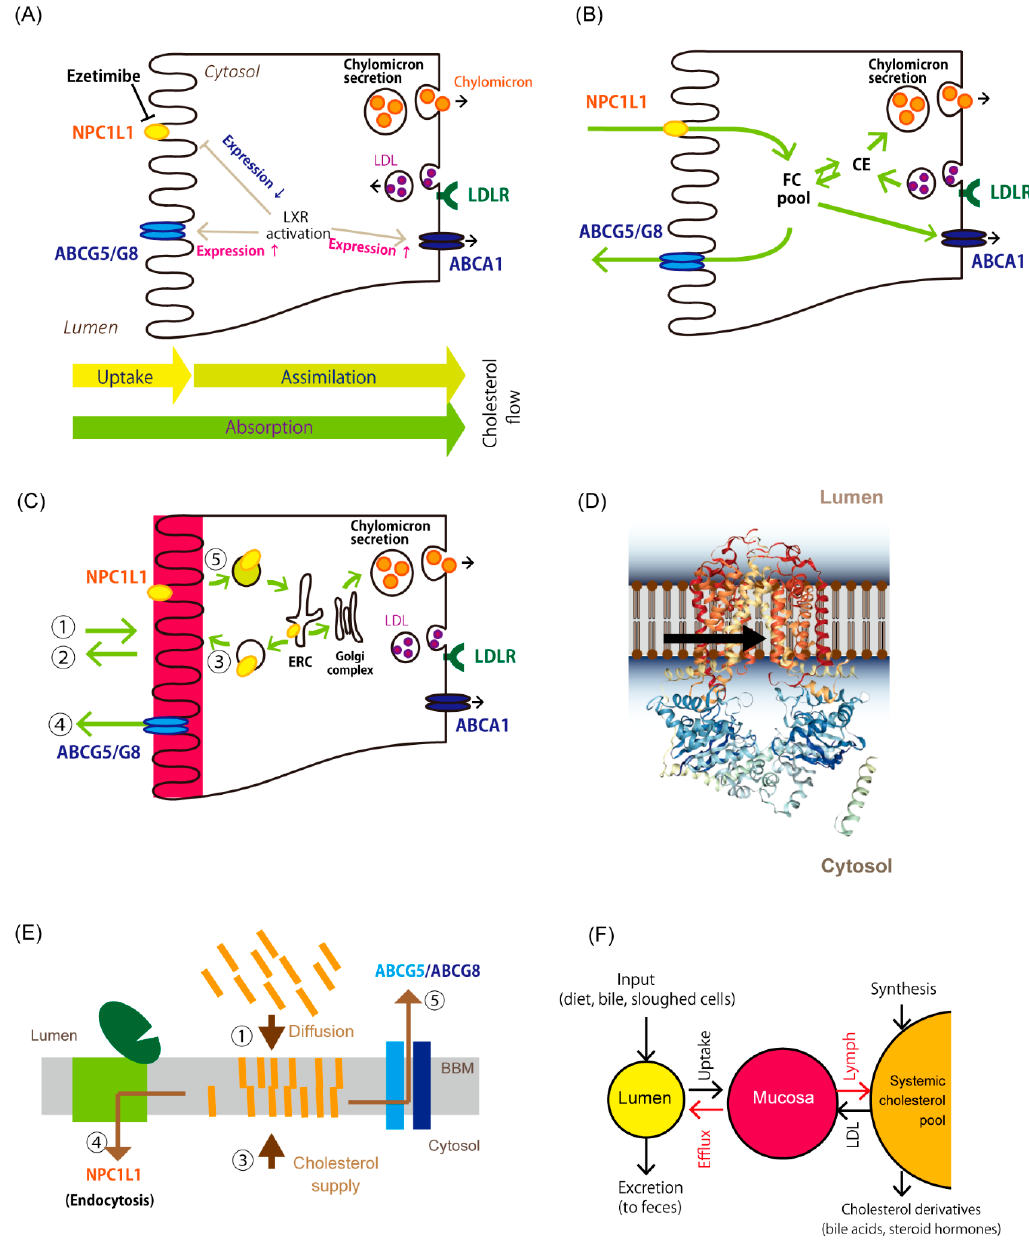
Figure 1. Overview of cholesterol trafficking in enterocytes. ( A ) Components associated with cholesterol absorption in enterocytes. Niemann-Pick C1-like 1 (NPC1L1) is the major cholesterol transporter. ATP-binding cassette (ABC) G5/G8 is an efflux transporter of sterols in the brush border membrane (BBM). Liver X receptor (LXR) modulates gene expression, the products of which are associated with the fluxes. Enterocytes take up cholesterol as low-density lipoprotein (LDL) via LDL receptor-mediated endocytosis from the basolateral side [19]. Cholesterol in enterocytes exists mainly as chylomicrons or very low-density lipoprotein (VLDL) [20]. These lipoproteins carry triacylglycerol predominantly and other lipids as well, but the figures do not show them for simplicity. Cholesterol is also transported into the serosal side to build high-density lipoprotein via ATP-binding cassette A1 (ABCA1). Arrows indicate up-regulation. Gene expression of NPC1L1 is attenuated by LXR activation. The terms of “uptake”, “assimilation”, and “absorption” are defined in the text. Ezetimibe is an NPC1L1 inhibitor. ( B ) A current image about how cholesterol transits in enterocytes. Cholesterol in the lumen passes through the membrane via NPC1L1. ABCG5/G8 effluxes free (nonesterified) cholesterol (FC) in the cytosolic area. CE, cholesteryl ester. ( C ) A newly proposed model for